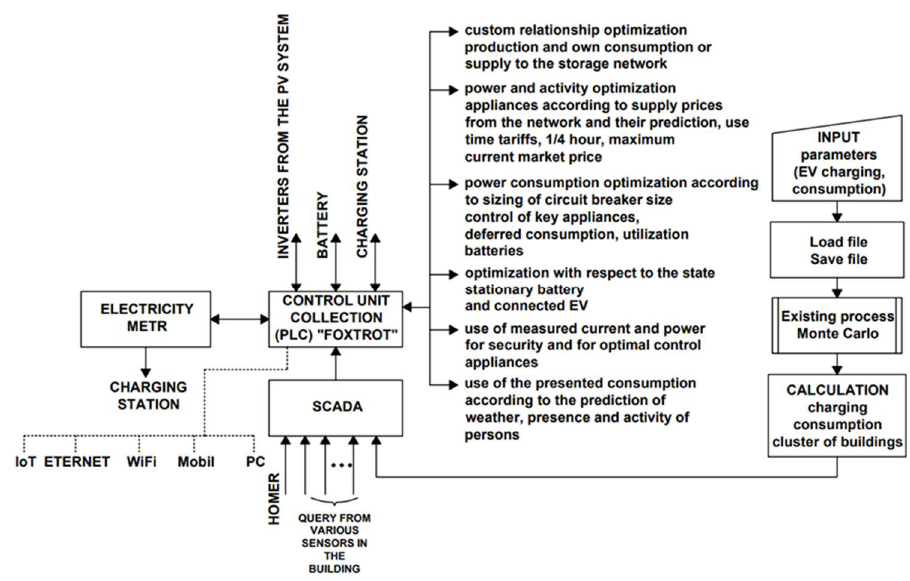
Figure 25. Control of charging stations by FOXTROT.